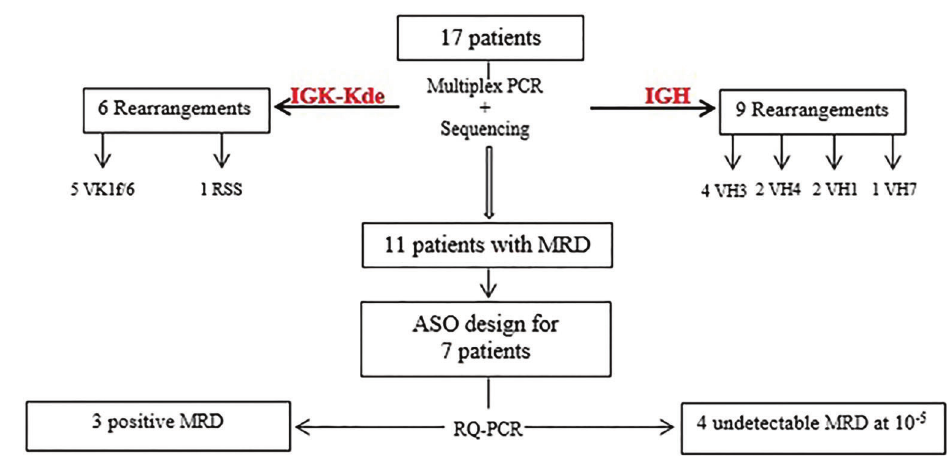
Figure 3. Consort diagram of patients. MRD: minimal residual disease; ASO: allele-speci fi c